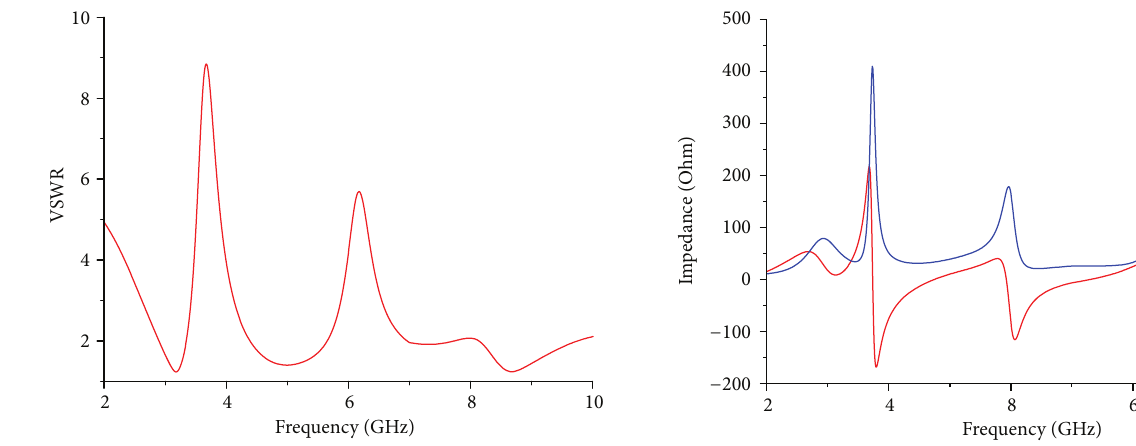
Figure 10: Simulated VSWR result of the proposed antenna.